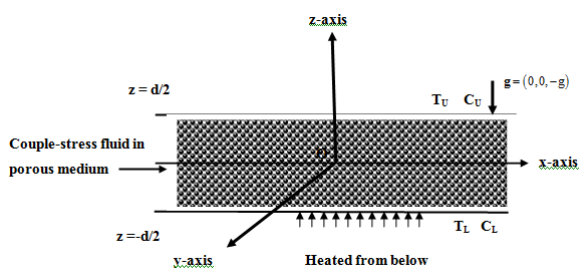
Figure 1: Geometrical configuration of the